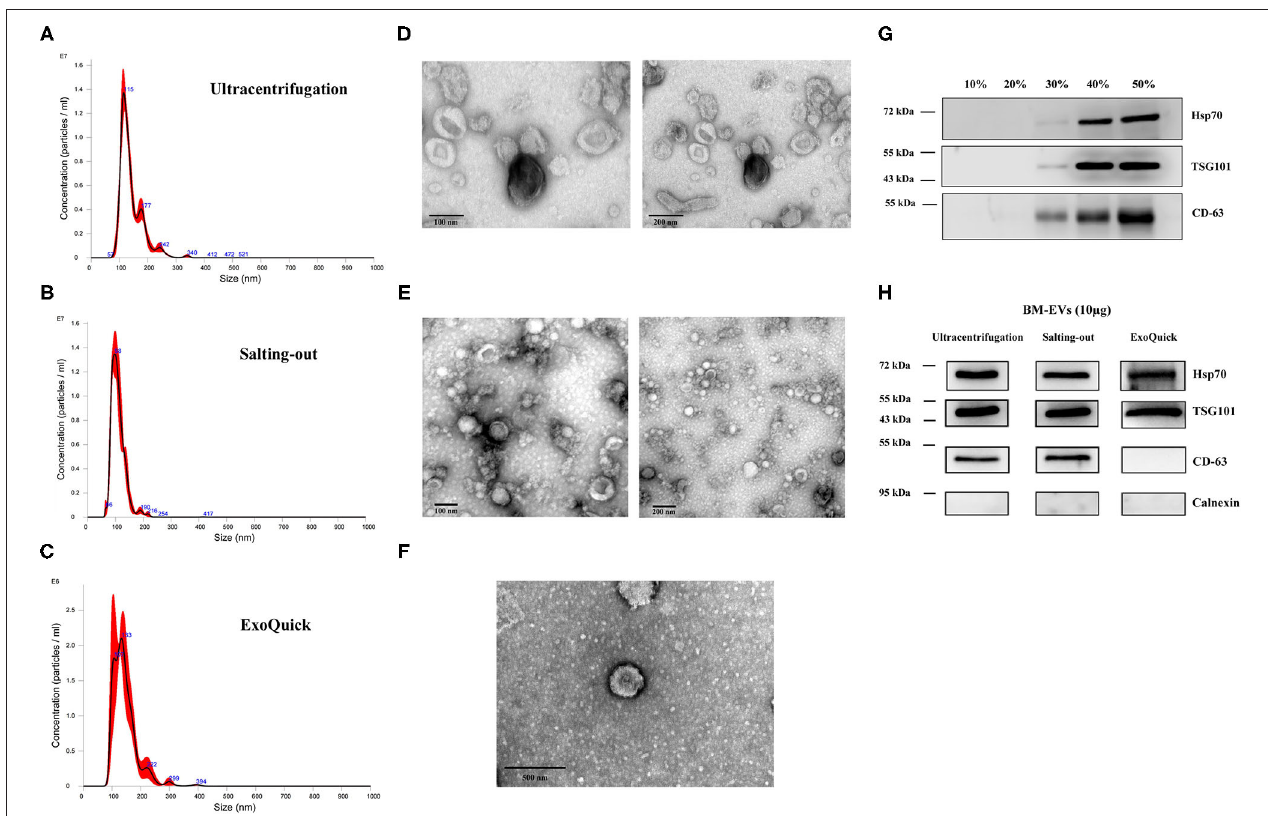
FIGURE 3 | Characterization of BM-EVs. The size distribution of isolated BM-EVs was analyzed by nanoparticle tracking analysis (A–C) . Transmission electron microscopy observation of BM-EVs separated by three different methods (D–F) . The protein markers (CD63, TSG101, Hsp70) of BM-EVs using different saturation of ammonium sulfate (G) . Western blotting of BM-EVs isolated via salting-out, ultracentrifugation or ExoQuick method (H)